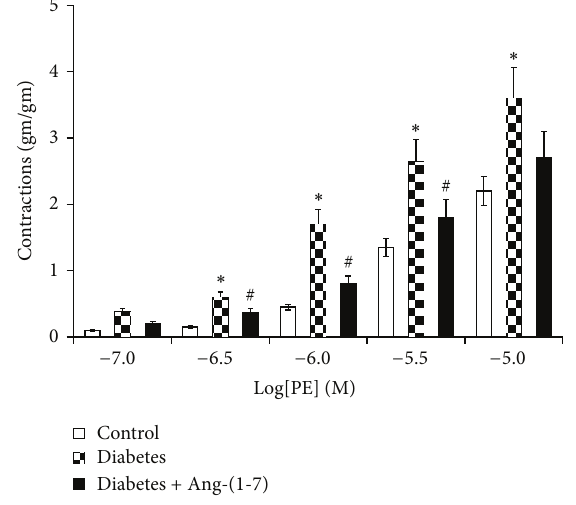
Figure 2: Phenylephrine-induced vasoconstriction in the corpus cavernosum segments from nondiabetic (control), diabetic, and diabetic rats treated with Ang-(1-7) (Mean ± SEM, 𝑛 = 6 –8). Asterisk ( ∗ ) indicates significantly different mean values as compared to control, and hash (#) indicates significantly different mean values as compared to diabetes. 𝑃 < 0.05 . Tissues isolated from 6-week diabetic rats treated with Ang-(1-7) for the last three weeks of the study.